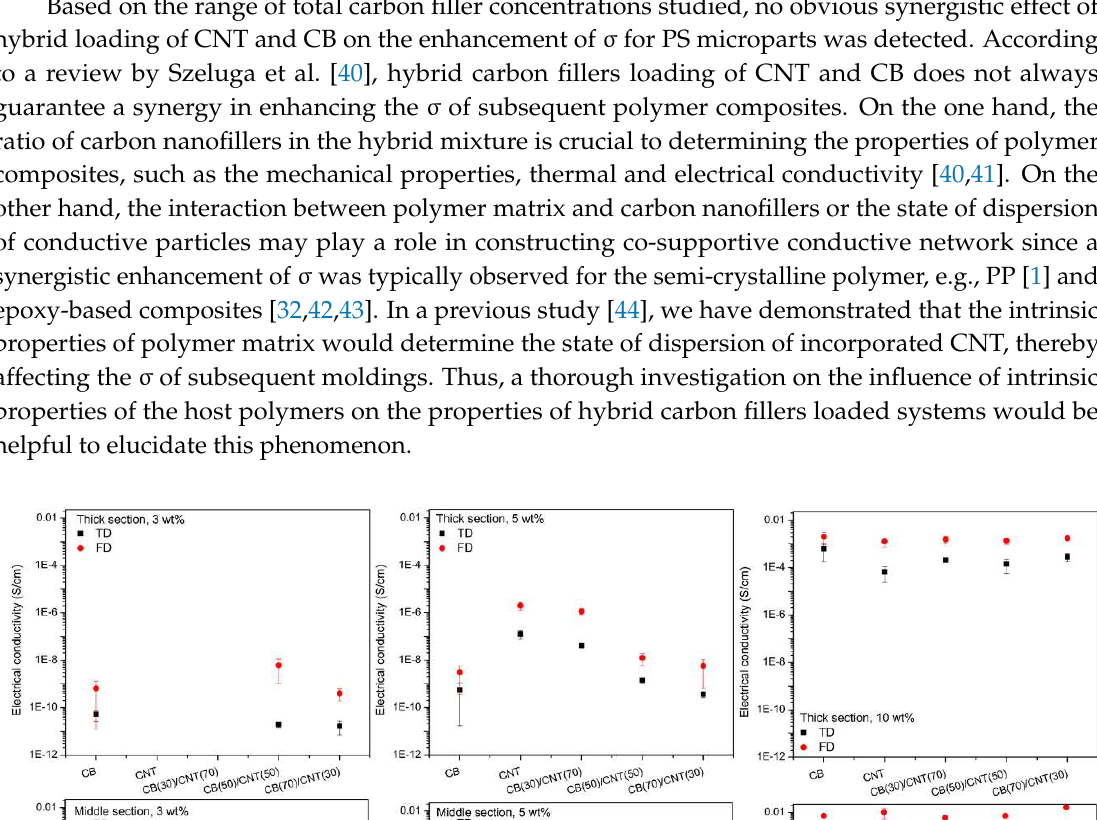
Table 3. The average σ for the thick section of 10 wt % carbon fillers loaded PS microparts.